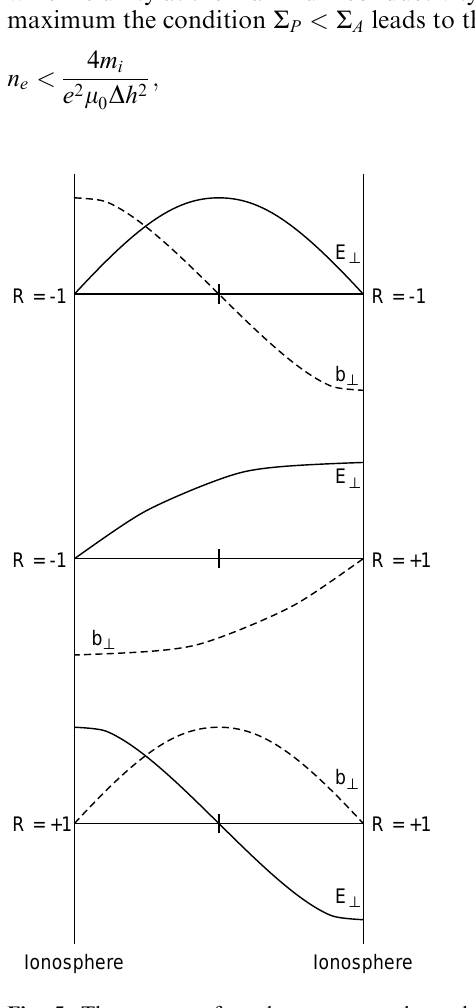
Fig. 5. Three cases of mode structures along the field line for di(cid:128)erent ionospheric conditions: the first half harmonic with electric nodes in the ionospheres on the top, the first quarter harmonic in the middle and the first half harmonic with electric antinodes in the ionospheres in